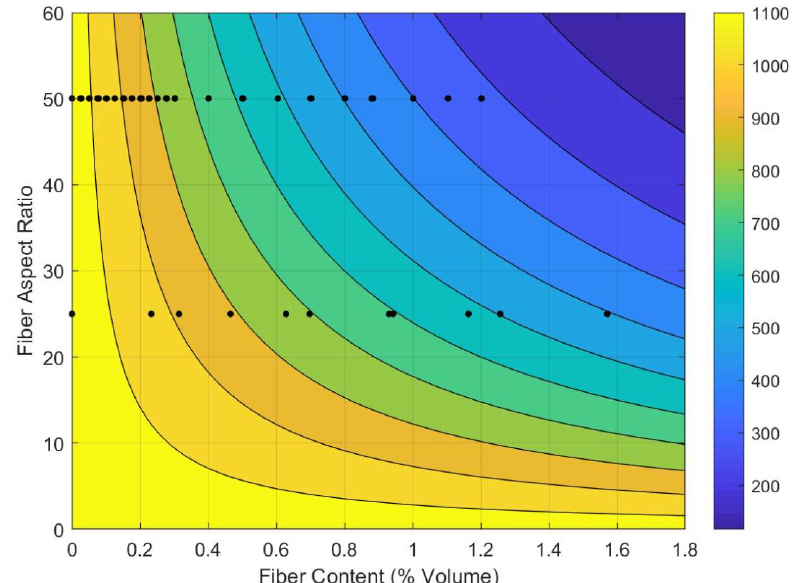
Figure 10. The surface electrical resistance ( Ω · m) contour map for the proposed fit.